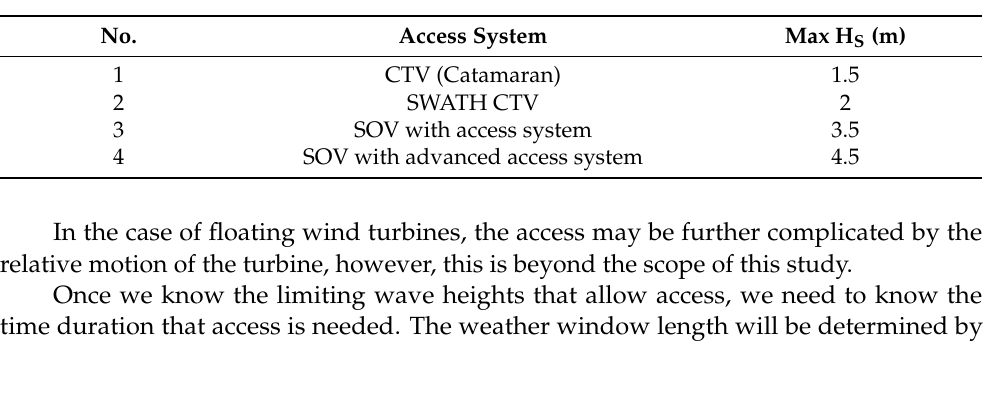
Figure 2. Summary of the research process [11].